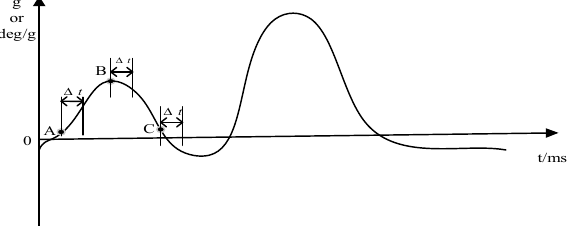
Figure 10. Synchronous and asynchronous acquisition comparison.